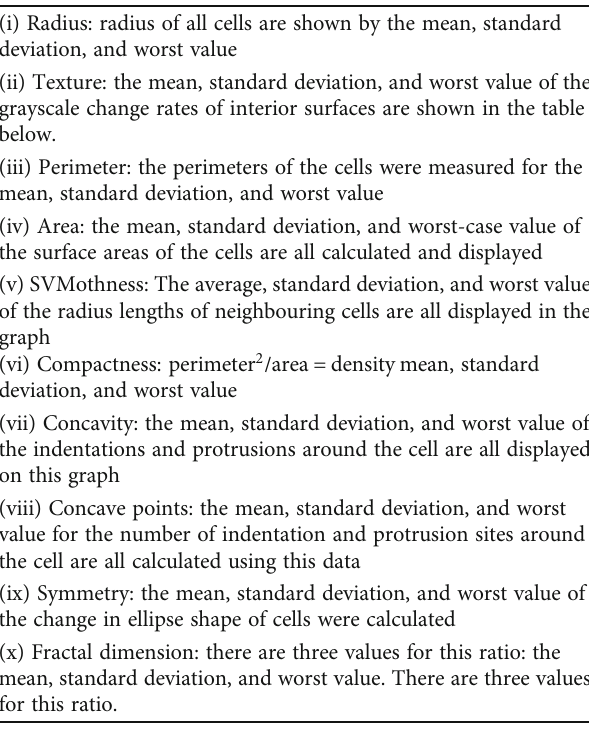
Figure 2: Image of a malignant tumor